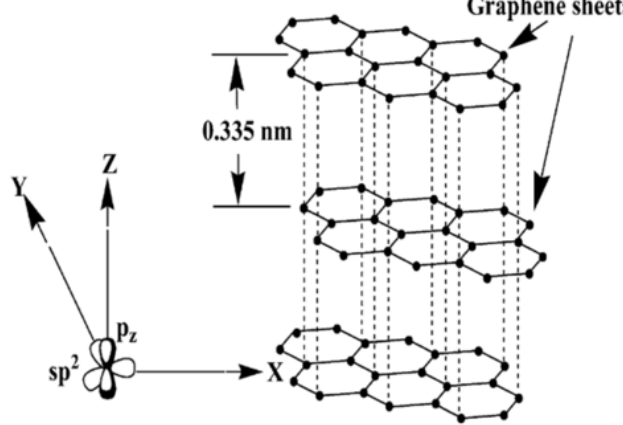
Figure 25. Layered graphite structure showing sp 2 -hybridized carbon atoms tightly bonded in hexagonal rings. Reprinted from [87], Copyright 2011, with permission from Elsevier.